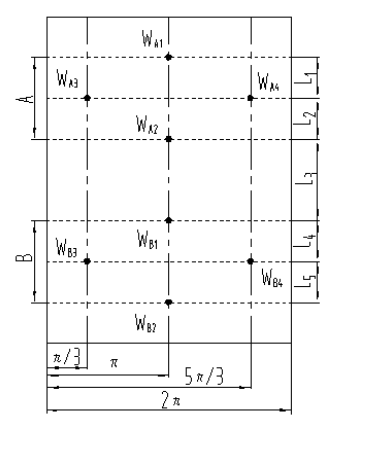
Fig. 2 Expanded layout of the driving wheel position on the